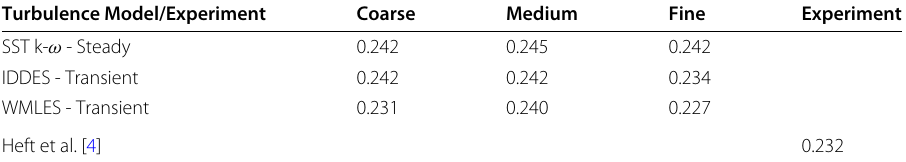
Table 2 Overall drag coefficients from CFD compared to experimental data for the baseline model Turbulence Model/Experiment Coarse Medium Fine Experiment SST k- ω - Steady 0.242 0.245 0.242 IDDES - Transient 0.242 0.242 0.234 WMLES - Transient 0.231 0.240 0.227 Heft et al. [4]